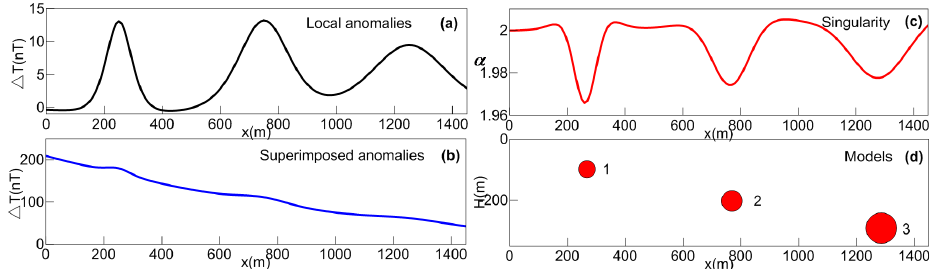
Fig. 4. Illustration showing weakly magnetic anomaly extraction using the singularity mapping technique for the profile at y=500m in Fig. 2c: (a) local magnetic anomaly; (b) total magnetic anomalies which are the superposition of the local anomalies on the regional field; (c) estimated local singularity α value, and (d) model profile.